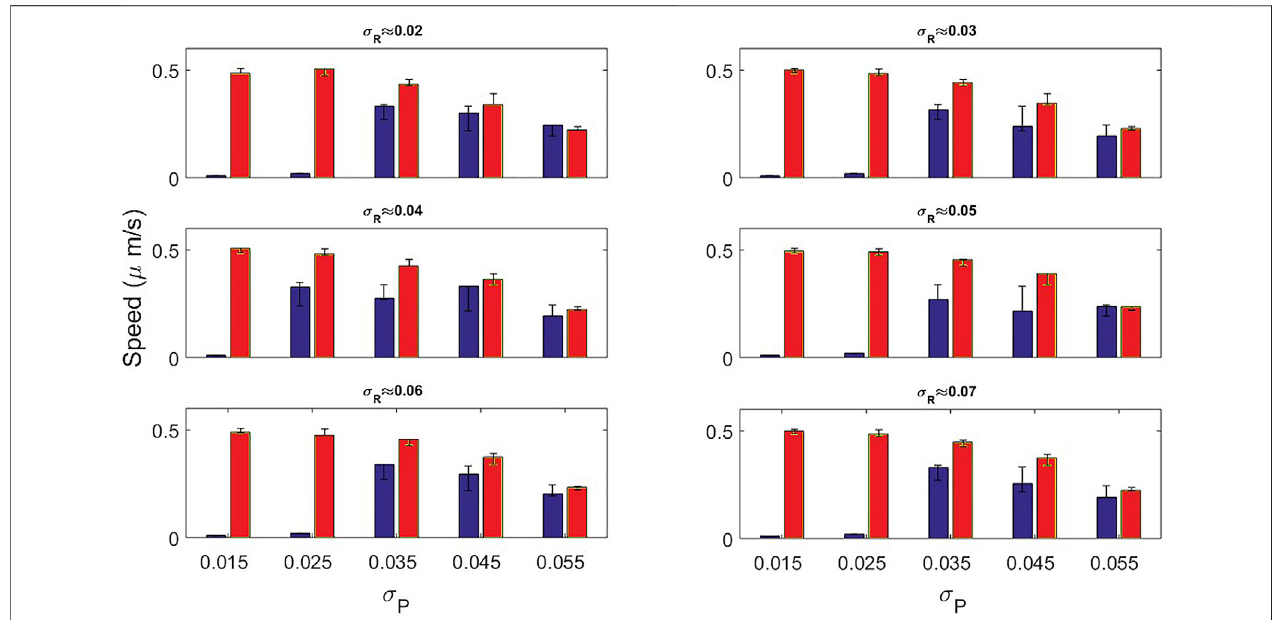
Frontiers in Physics |